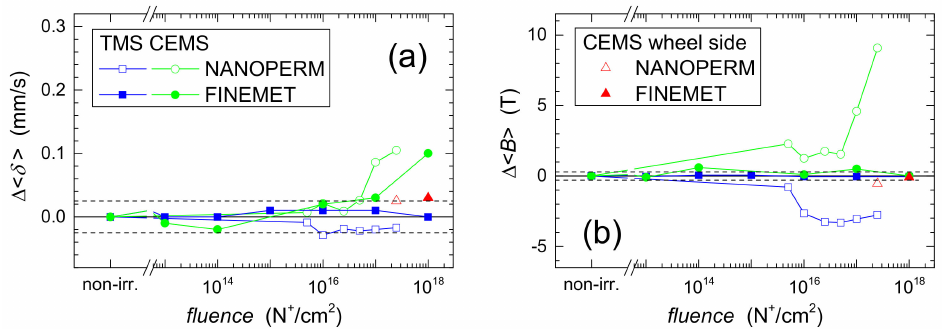
Figure 11. Differences of parameters derived from transmission (TMS, blue) and CEMS (green) Mössbauer spectra of Fe 74 Cu 1 Nb 3 Si 16 B 6 (FINEMET-type, solid symbols) and Fe 76 Mo 8 Cu 1 B 15 (NANOPERM-type, open symbols) metallic alloys irradiated by 110 keV and 130 keV N + ions, respectively, plotted against the ion fluence: ( a ) average isomer shift, ∆ (cid:104) δ (cid:105) ; ( b ) average hyperfine magnetic field, ∆ (cid:104) B (cid:105) . Red triangles correspond to CEMS spectra taken from the wheel side of the ribbons. Solid lines are only guides for the eye, dashed lines represent the error